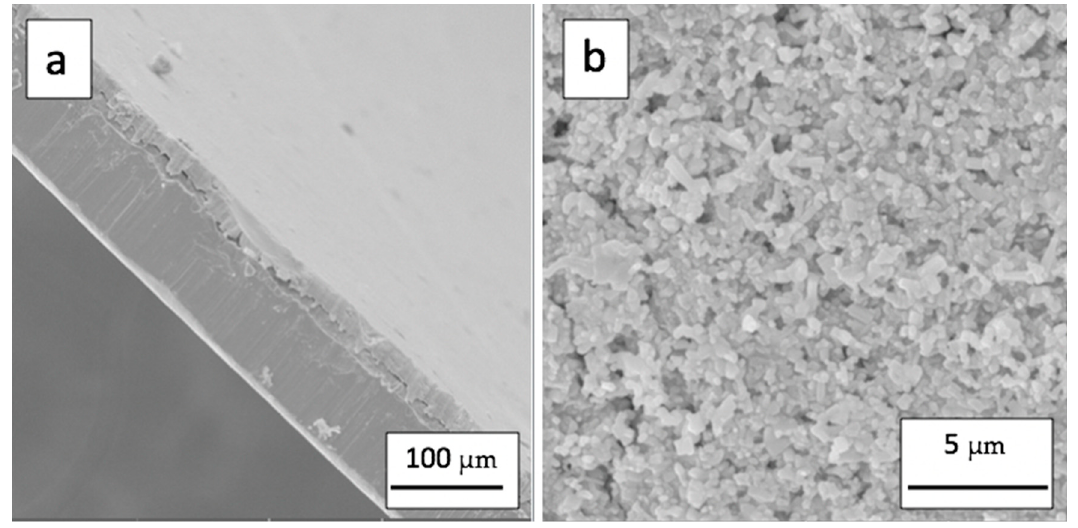
Figure 5. ( a ) SEM images of the cross-section of the nanocomposite thin film, ( b ) SEM micrograph of the fractured surface of ZnO and Graphene nanoplatelets agglomerations appear in SEM image for ZnO VF of 0.6.